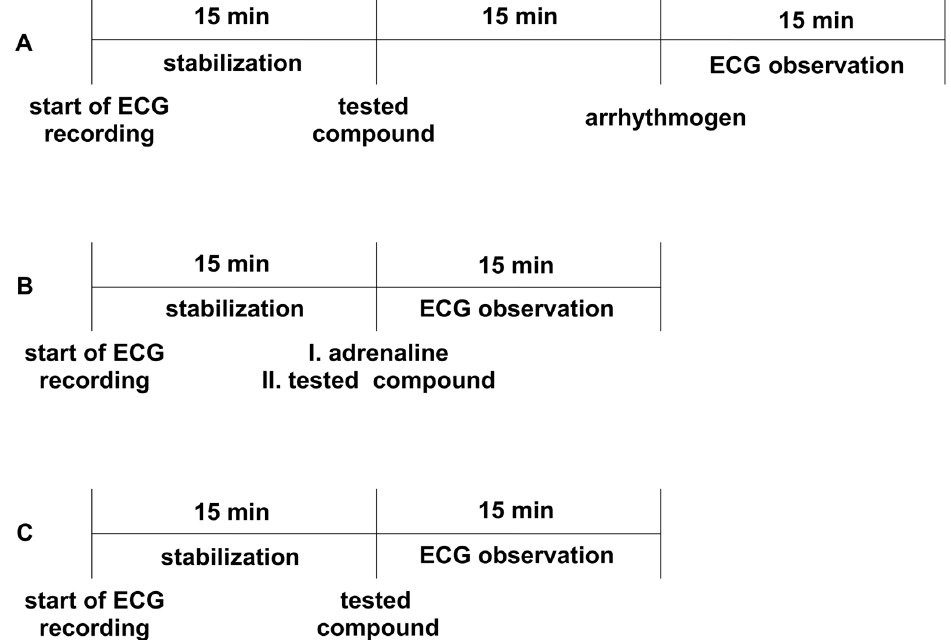
Figure 3. The experimental setup for studying prophylactic (Panel A ) and therapeutic (Panel B ) antiarrhythmic activity in rat models of arrhythmia, as well as the influence on electrocardiogram (ECG)_ parameters (Panel C ). Adrenaline (20 µ g/kg), calcium chloride (140 mg/kg), or aconitine (20 μ g/kg) were used as arrhythmogens. All the compounds were administered intravenously ( iv ). The ECG observation was during the first 2 min and in the 5th, 10th, and 15th min.